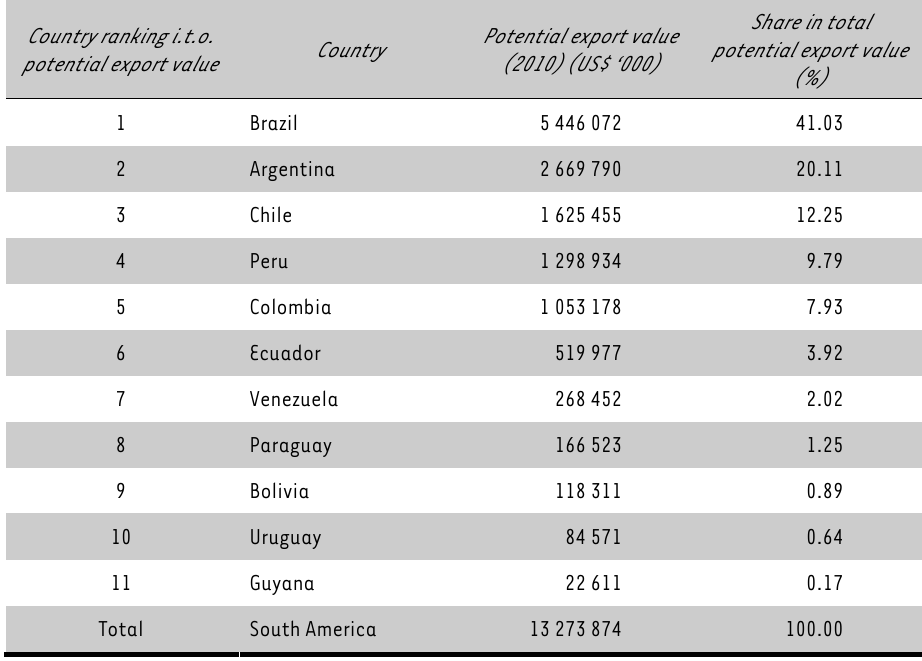
TABLE 9: South American countries ranked according to their total potential export value for South Africa Country ranking i.t.o.